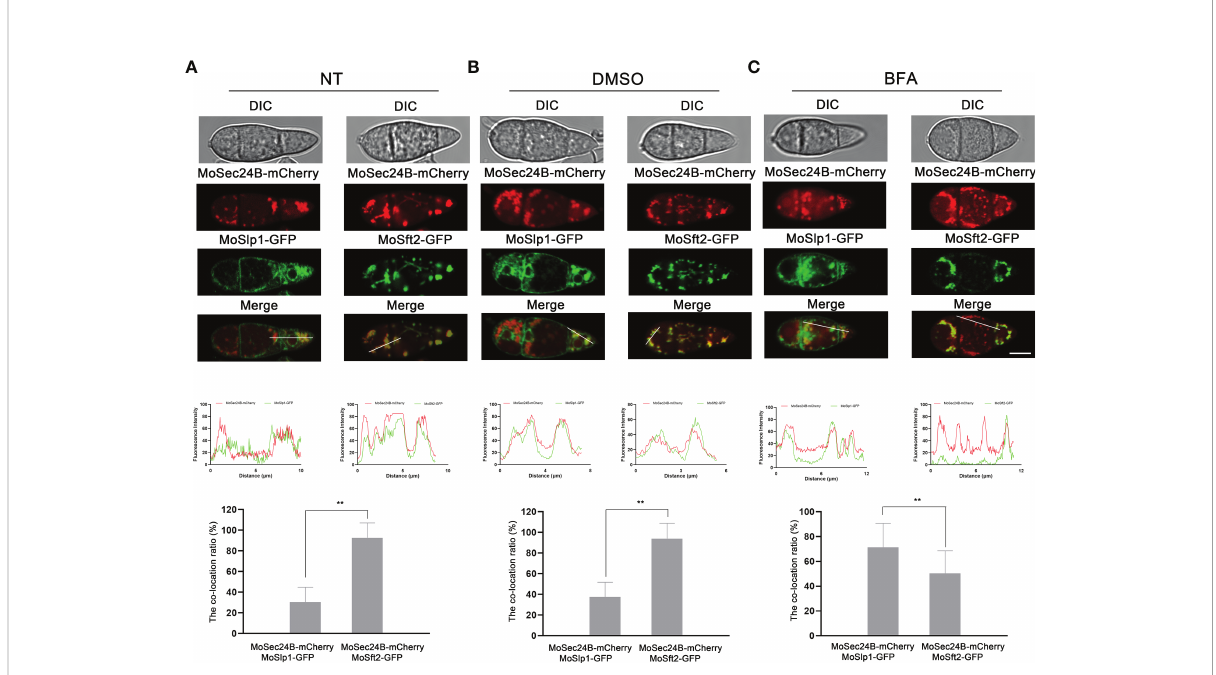
FIGURE 2 Subcellular localization of MoSec24B in M. oryzae . (A) Confocal fl uorescence microscopy images observed the co-localization of MoSec24B- mCherry with ER-localized marker MoSlp1-GFP and Golgi-localized marker MoSft2-GFP, respectively, in untreated conidia (Fv3000, 60 × oil). (B) Confocal fl uorescence microscopy images observed the co-localization of MoSec24B-mCherry with ER-localized marker MoSlp1-GFP and Golgi-localized marker MoSft2-GFP, respectively, in 0.1% DMSO-treated conidia (Fv3000, 60 × oil). (C) Confocal fl uorescence microscopy images observed the co-localization of MoSec24B-mCherry with ER-localized marker MoSlp1-GFP and Golgi-localized marker MoSft2-GFP, respectively, in BFA-treated conidia (Fv3000, 60 × oil). Scale Bar = 5 m m. Fifteen spores were selected under each treatment (Normal, DMSO, BFA), the reticular or spot-like structures representing the ER and Golgi in each spore were labeled as number A, and the MoSec24-mCherry, which co-located with green fl uorescence in each spore, was labeled as number B. (B/A) *100 was calculated as the co-localization percentage. The bar graphs indicate the percentage of localization of MoSec24B-mCherry in ER and Golgi, respectively, under different treatment conditions. Error bars represent the standard deviation. An analysis of the data was carried out using an unpaired two-tailed Student ’ s t-test. Asterisks represent statistically signi fi cant differences in the data (**P <